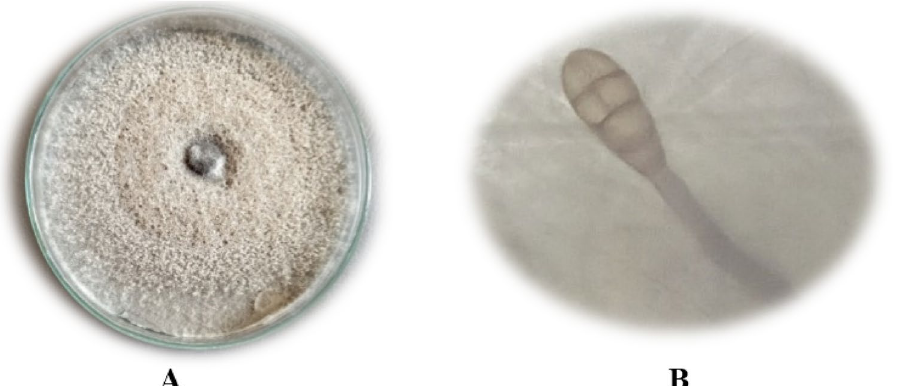
Figure 1. Alternaria alternata growth on a Petri dish ( A ) and conidiophore bearing the septated conidium was photographed under a light microscope 40x ( B ).